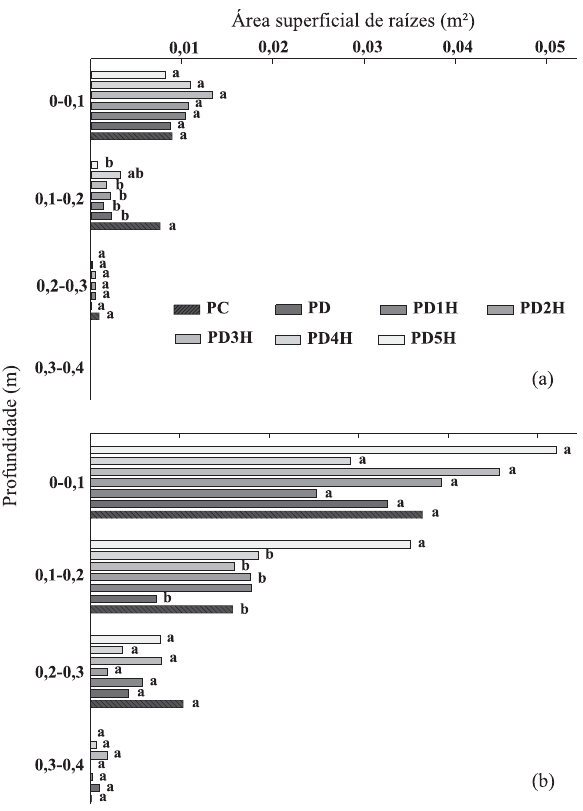
Figura 4. Distribuição do sistema radicular da me- lancia em profundidade 30 d após a semeadura (a) e 60 d após a semeadura (b). (PC: